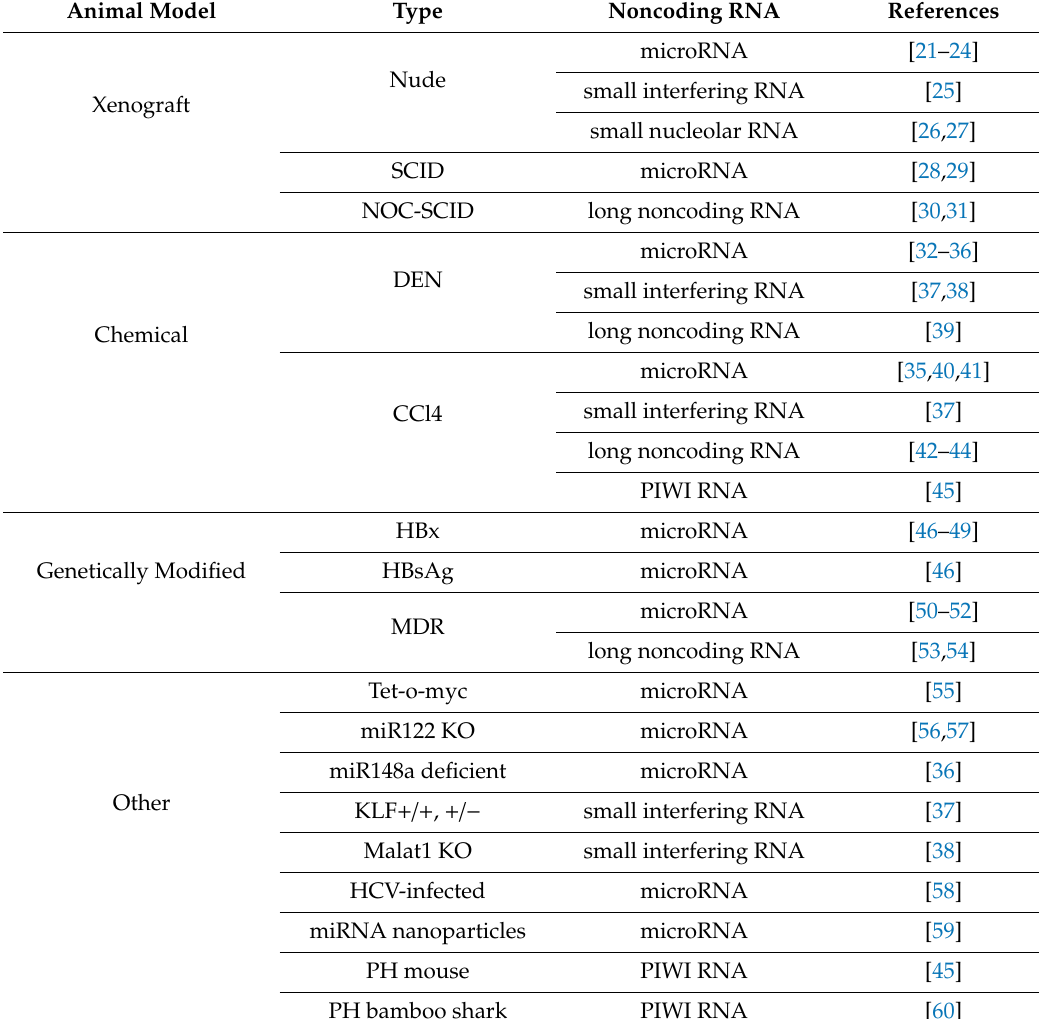
Table 1. Summary of noncoding RNAs and the corresponding experimental animal